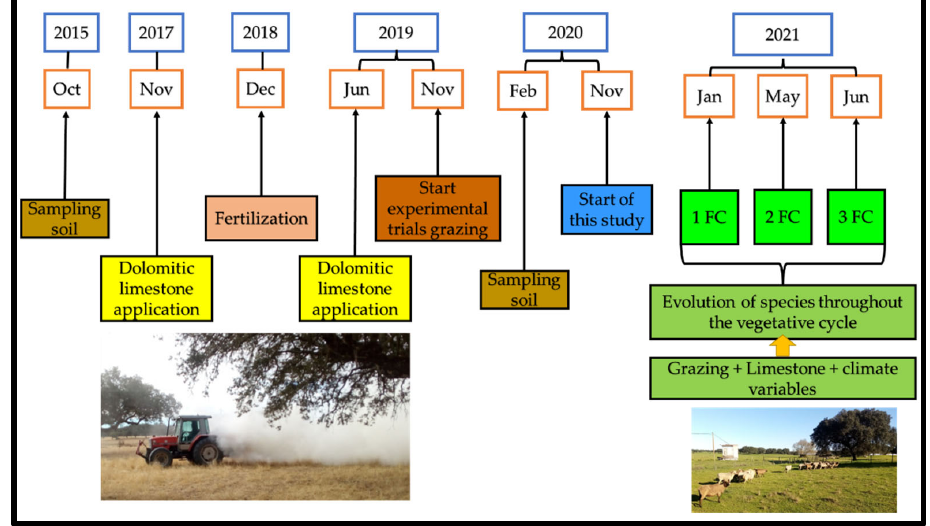
Figure 1. Chronological diagram of the study, with its framework in the research project of soil and pasture monitoring, in the Montado ecosystem (FC—characterization of floristic composition). pasture monitoring, in the Montado ecosystem (FC—characterization of floristic